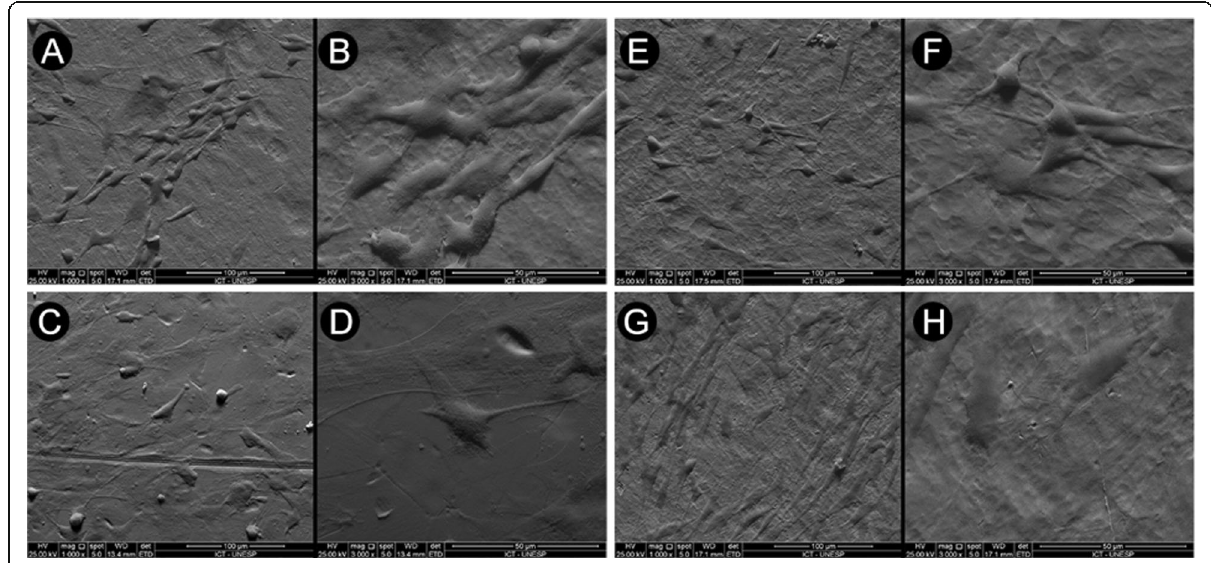
Fig. 2 Scanning electron micrographs of the samples after cell culture showing cell adhesion and spread. At low magnification ( a , c , e , g ), it was possible to see cell adhesion. At high magnification ( b , f , d , h ), it was possible to see better cell interaction with the samples ’ surfaces, with an increase of lamellipodia and filopodia, mainly in the titanium alloy and niobium samples. a , b TiNbZr; c , d pure titanium; e , f Nb; g , h Zr. Scale bar 50 μ m